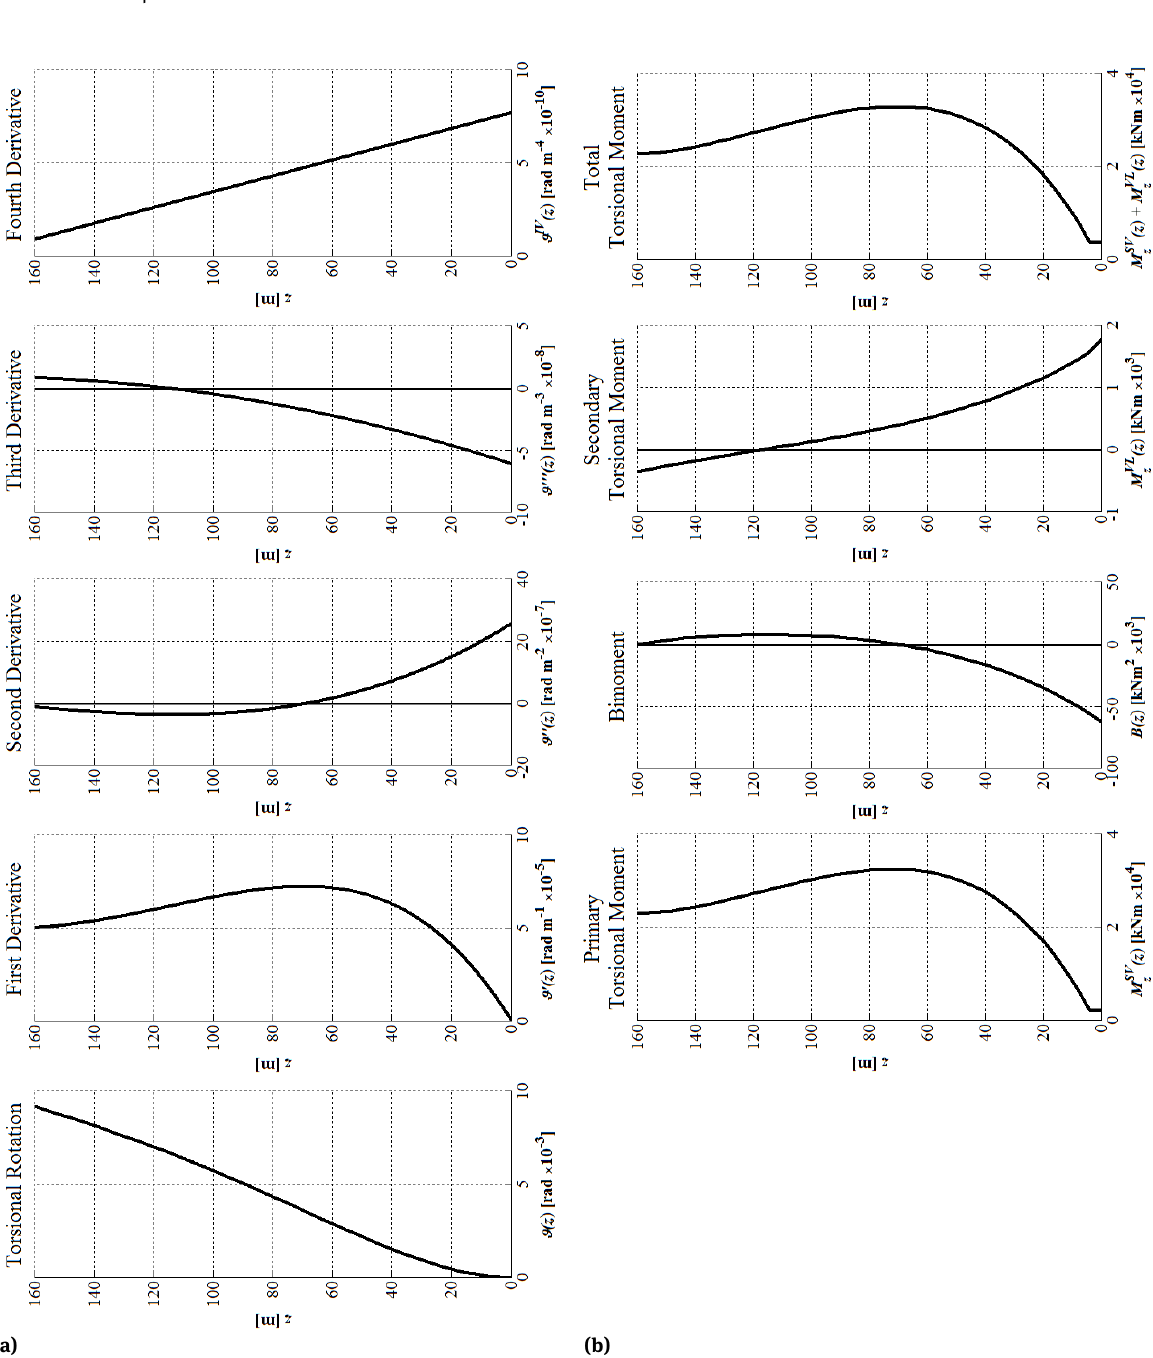
Figure 11: (a) Torsional rotation ϑ ( z ) of each floor and its successive derivatives; (b) Global internal actions M SV z ( z ) , B ( z ) , and M VL z ( z )